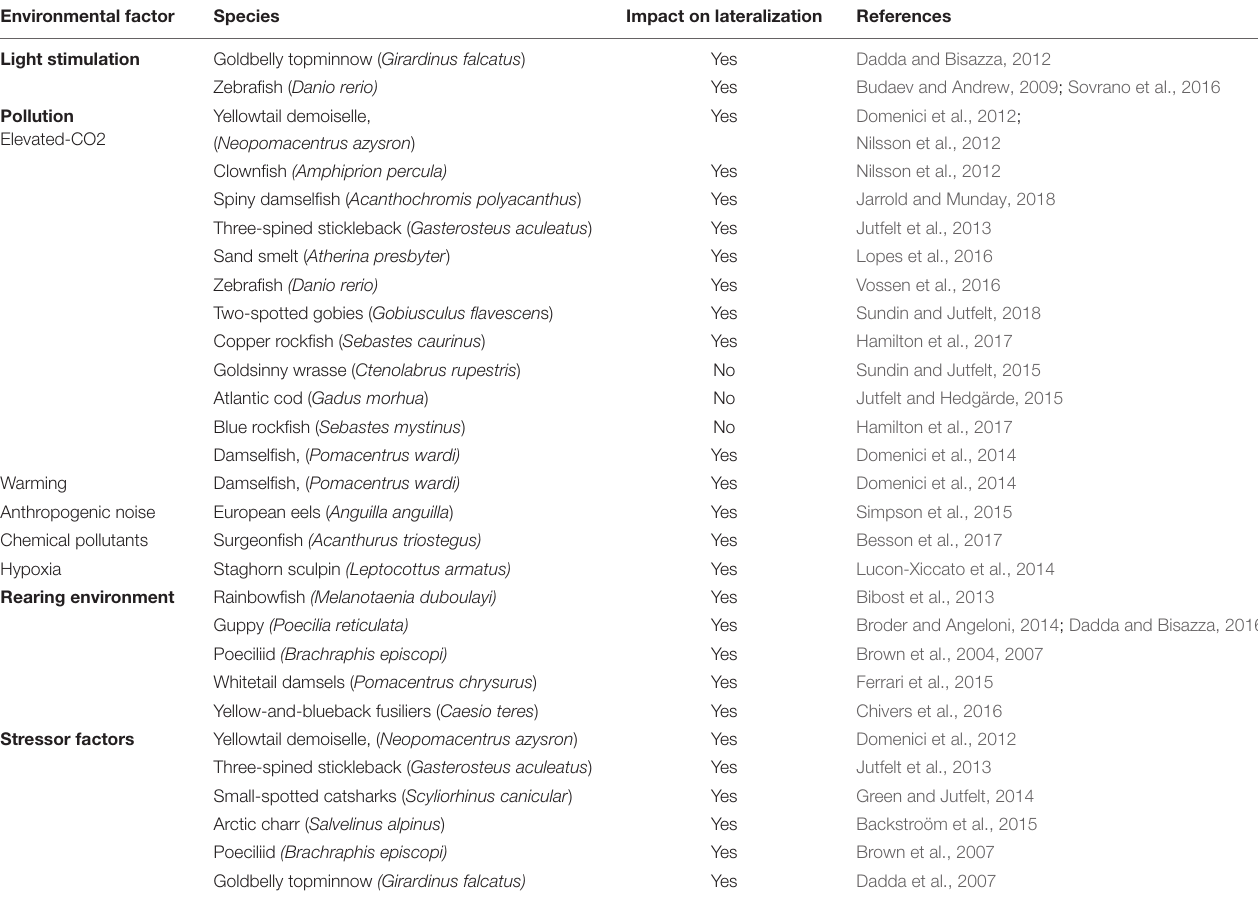
TABLE 2 | Environmental factors that influence the development of